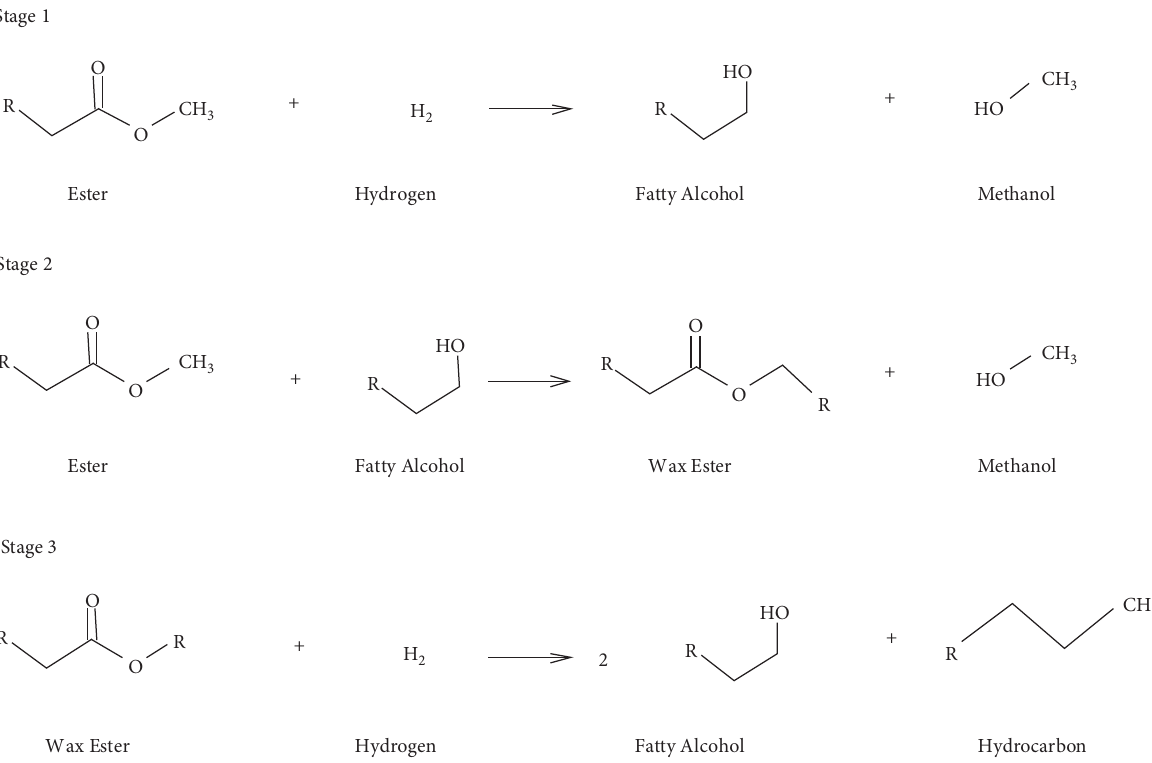
Figure 2: Reaction scheme for the conversion of esters to hydrocarbons.